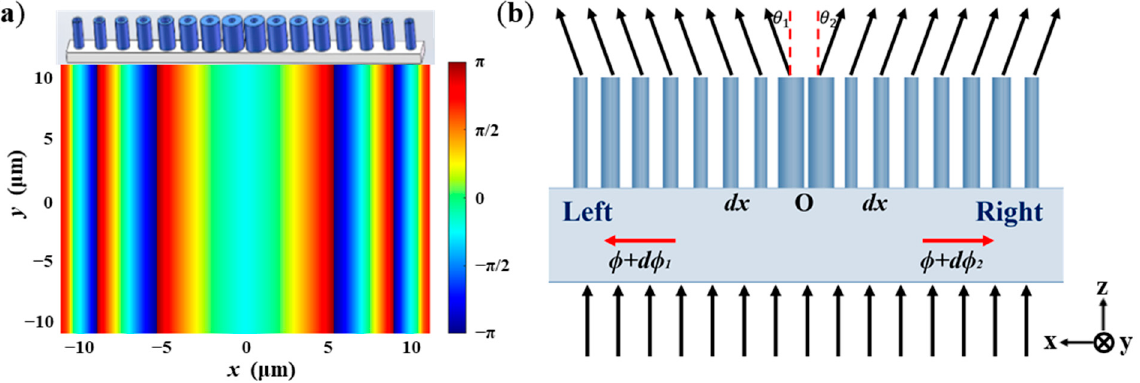
Figure 1. ( a ) The 3D structure and phase distribution of beam splitter design; ( b ) the schematic diagram of beam splitter orthograph.